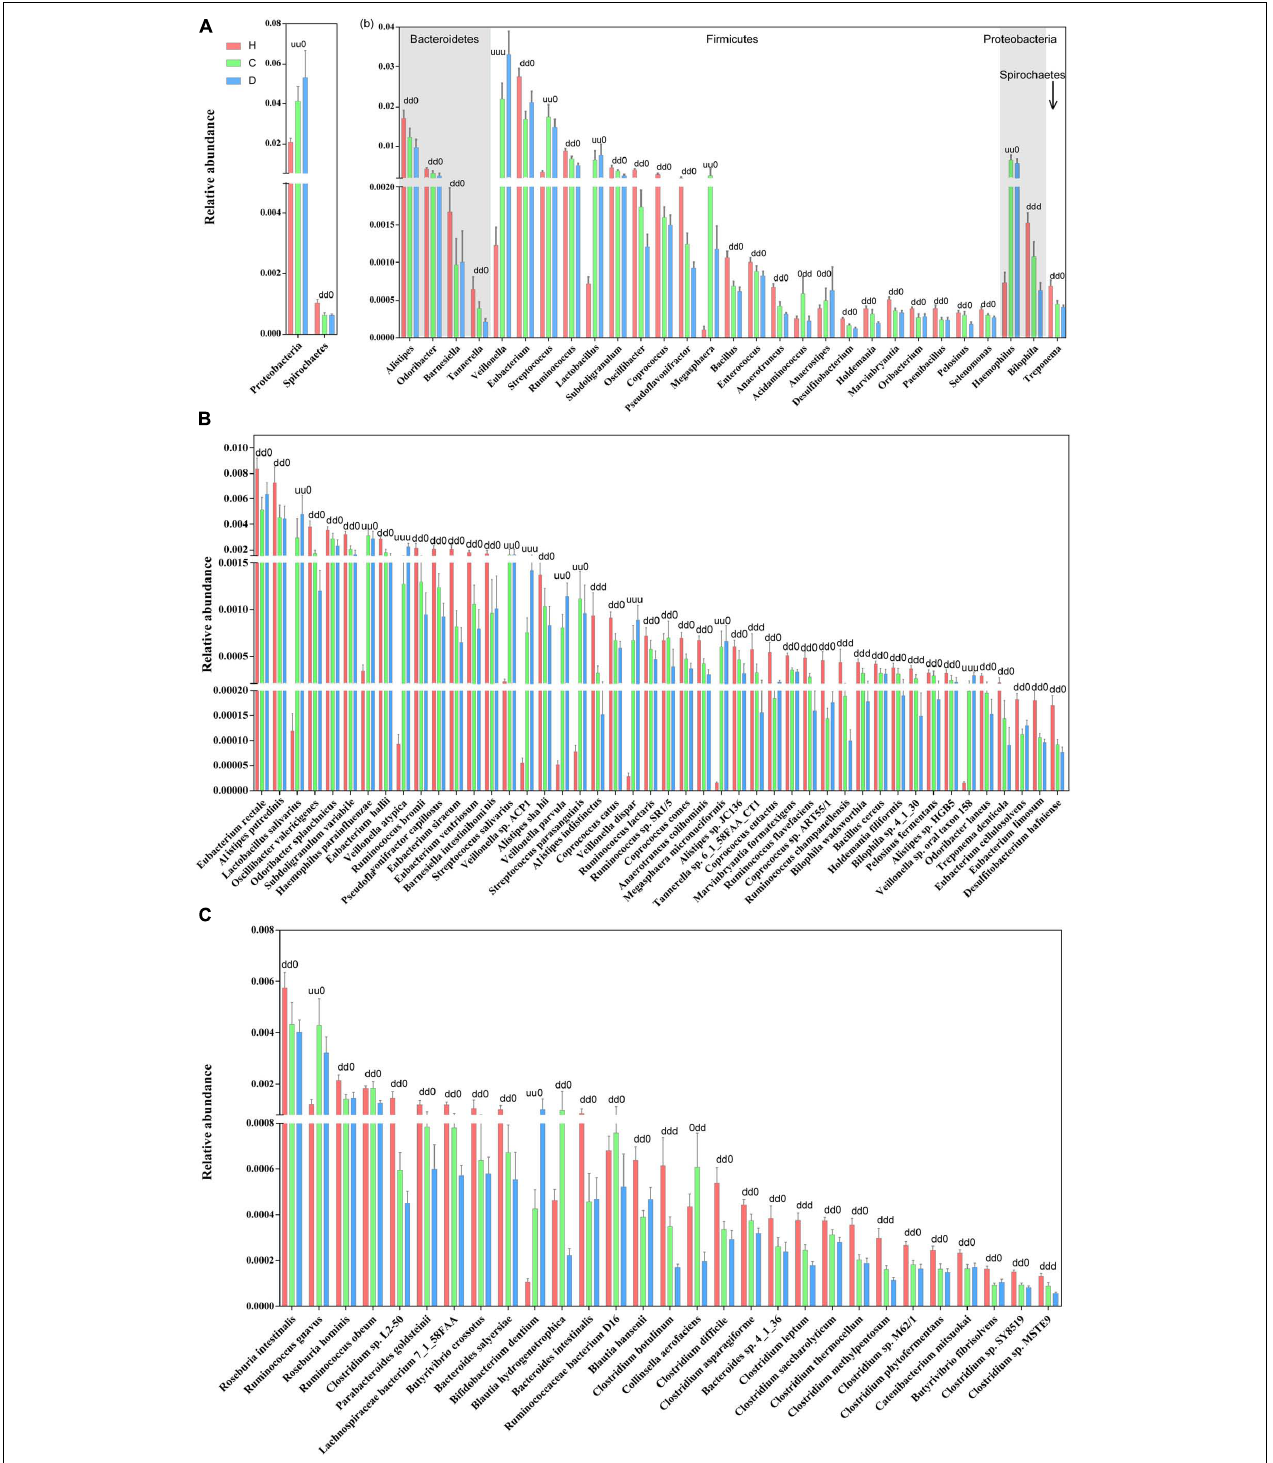
FIGURE 2 | Boxplots of differential gut microbiomes. (A) Relative abundance of differential phyla. (B) Relative abundance of differential genera. (C) Relative abundance of species demonstrating similar alterations with the corresponding genus in both compensated and decompensated patients, compared to healthy controls. (D) Relative abundance of species demonstrating different alterations with the corresponding genus in both compensated and decompensated patients, compared to healthy controls. A combination of three characters, “u,” “d,” and “0,” represents the status of compensated and decompensated patients compared to healthy controls and variations during sequential progression from the compensation to decompensation stage. “u,” “d,” and “0” signify significant upregulation and downregulation and no significant variations, respectively.